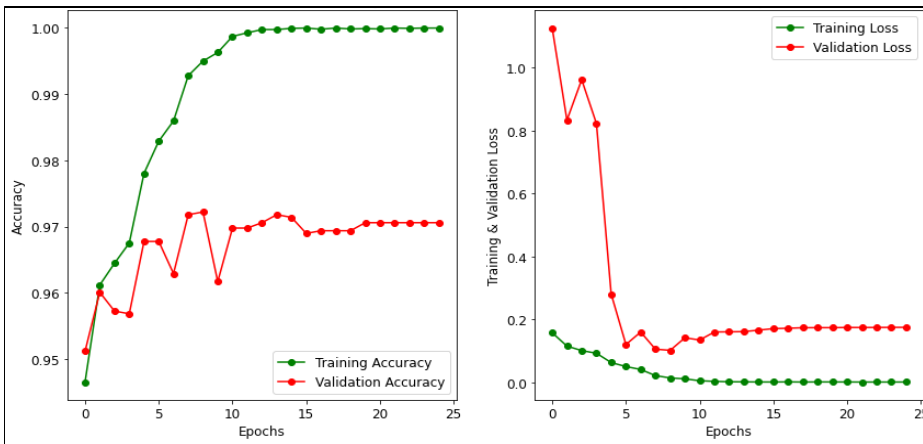
Figure 10. Accuracy and Loss of CNN model.